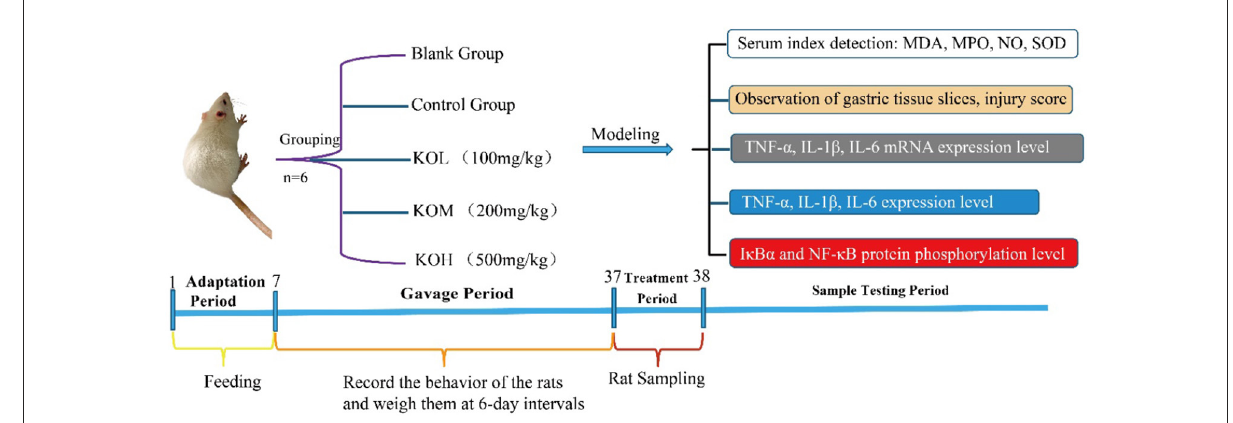
FIGURE1 Experimental schematic flow chart of KO protection against ethanol-induced acute gastric mucosal